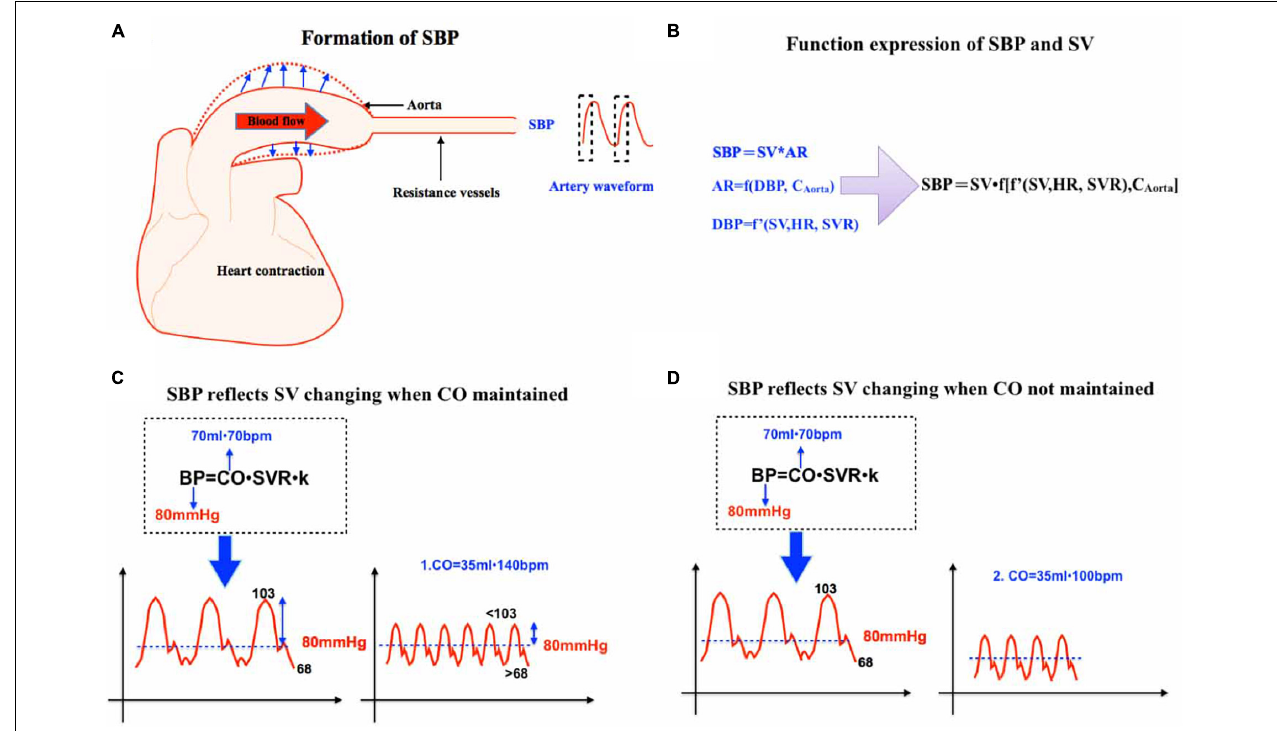
FIGURE 1 | (A) This is a schematic diagram of SBP formation. SBP begins with heart contraction and is proportional to SV and aortic resistance. (B) Function expression of SBP and SV. (C) SBP reflects SV changing when CO is maintained. SV 70 ml, HR 70 bpm, and MAP 80 mmHg is initially assumed. When SV decreases to 35 ml and HR to 140 bpm. If SVR is unchanged, MAP will remain unchanged but SBP will decrease because MAP gets closer to SBP with increased HR. (D) SBP reflects SV changing when CO is not maintained. SV 70 ml, HR 70 bpm, and MAP 80 mmHg is initially assumed. When SV decreases to 35 ml and HR only to 100 bpm, both MAP and SBP will significantly decrease. SBP, systolic blood pressure. SV, stoke volume. CO, cardiac output. SVR, systemic vascular resistance. HR, heart